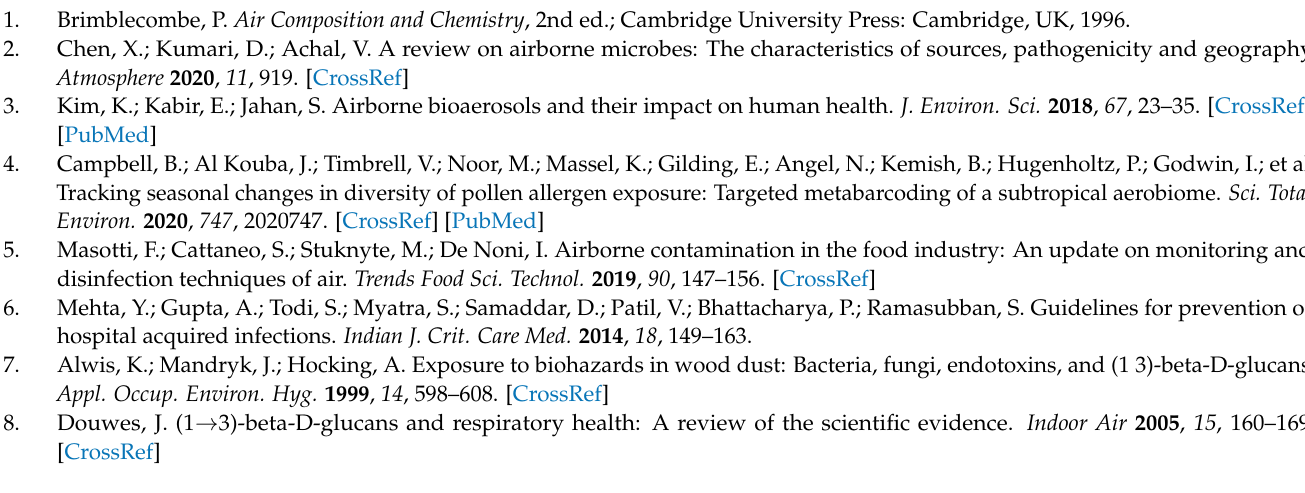
Table S3: Ranges of measured biomass parameters (2018–2019 and